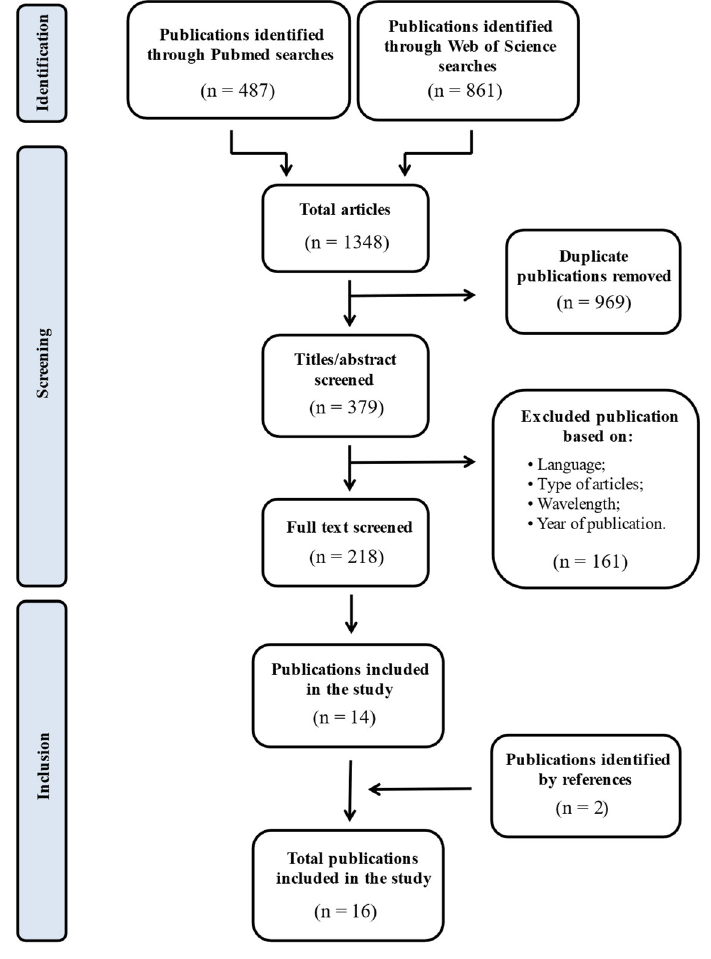
Figure 3. Selection procedure to find eligible publications.